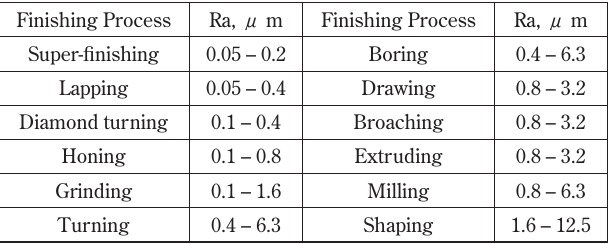
Table 1 Finishing process vs approximate range of Ra values 6)